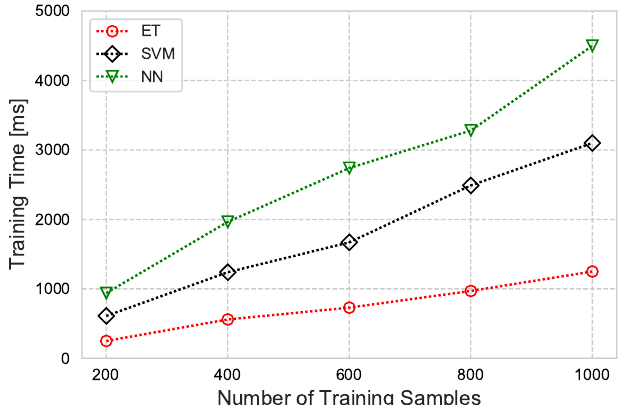
Figure 12. Training time based on the number of training samples for ET, SVM, and